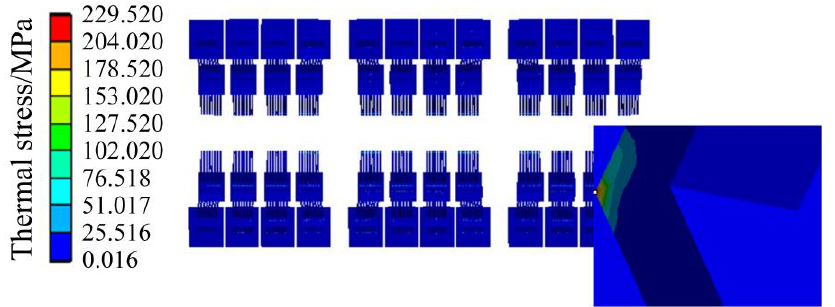
Figure 13. Thermal stress of the chip unit.